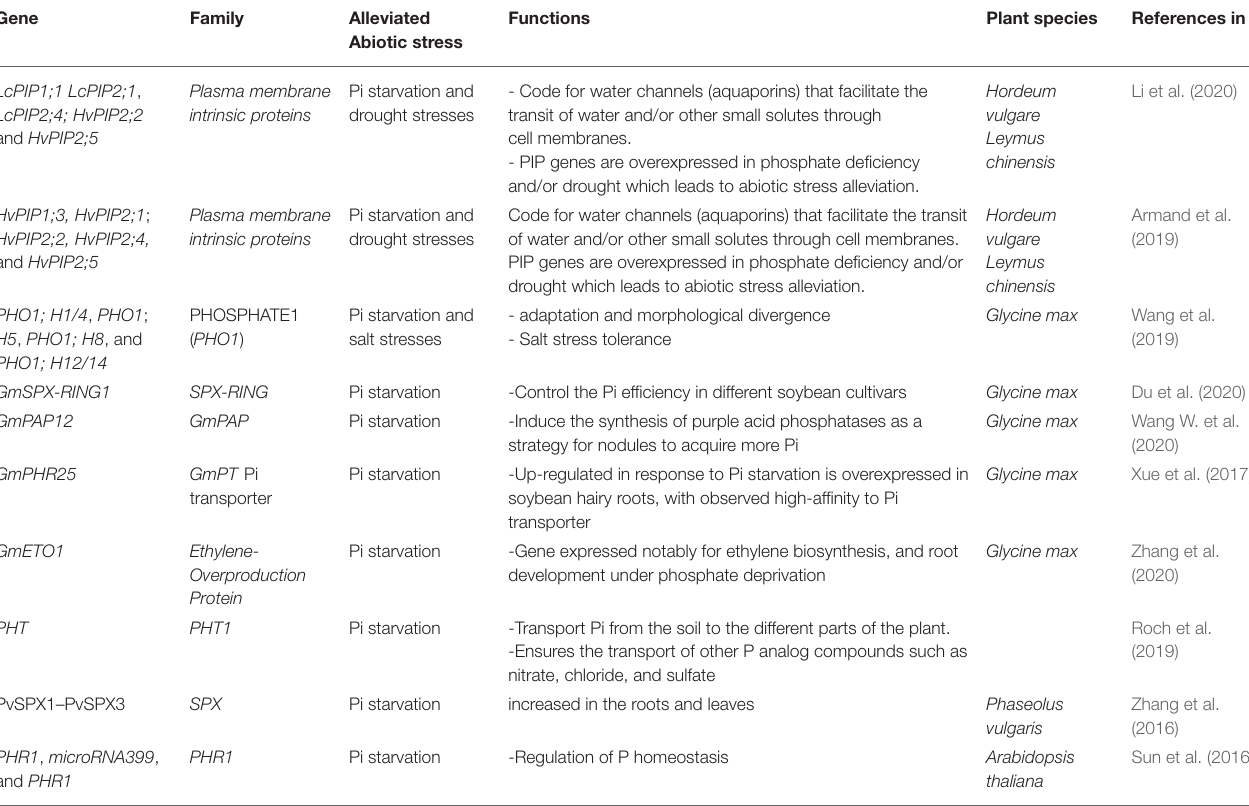
TABLE 1 | Names of genes, family, alleviated abiotic stresses, functions, isolated plant species, and cite references expressed in response to phosphate starvation, drought, and/or salinity stresses.